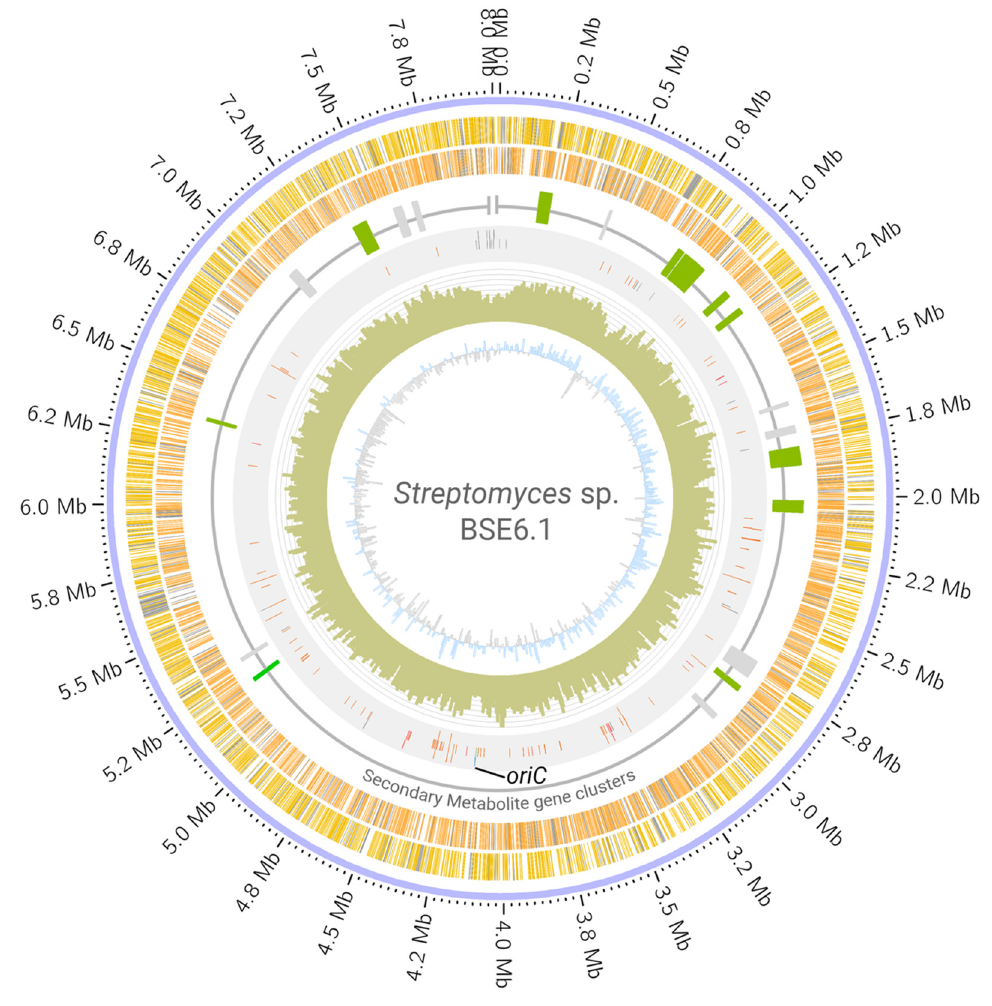
Figure 3. Circular visualization of Streptomyces sp. strain BSE6.1 genome. The scaffold is represented in the outer circle. The scaffold is followed by coding regions (CDS) in the sense (yellow bands) and anti-sense (orange bands) directions. Grey bands represent hypothetical CDS. The third circle represents the distribution of gene clusters coding for secondary metabolites (green: clusters which are >75% similar to those present in related organisms; grey: <75% similarity). The fourth circle represents the RNA genes (orange), transposases (grey), phage genes (purple) dnaA gene (blue), and oriC region (green and labelled). Histograms in the fifth circle indicate the GC content per 10,000 bases. The innermost circle represents GC skew data per 10,000 bases (blue indicates positive skewness and grey negative skewness).